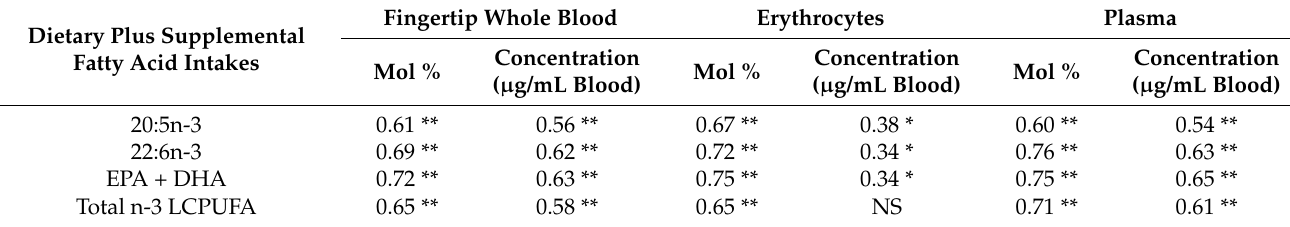
Table 1. Spearman’s correlation coefficients (r s ) for associations between the sum of dietary (as measured by FFQ) and supplemental intakes of n-3 LCPUFA and post-intervention blood biomarker levels (mol %) and concentrations ( µ g/mL blood) ( n = 45 for erythrocytes and plasma, n = 43 for fingertip whole blood).